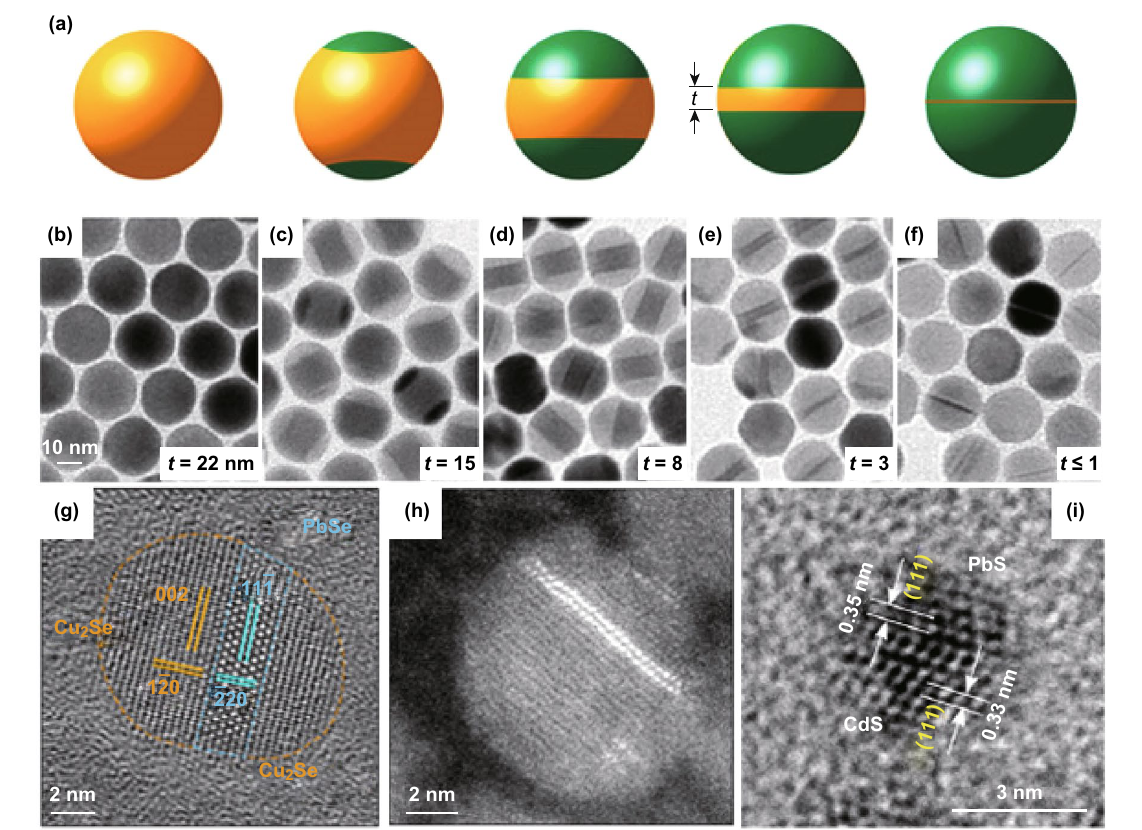
Fig. 3 a Schematic illustration of the cation exchange transformation of Cu 1.8 S NCs into sandwich‑like heterostructures with ZnS caps. b–f TEM images show the composition change from the initial Cu 1.8 S NCs b into ZnS f with a thin layer of Cu 1.8 S. The Cu 1.8 S disk thickness (t) is indicated. Reproduced with permission from Ref. [89]. Copyright 2014, American Chemical Society. g Scanning transmission electron micros‑ copy (STEM) image of a single partially exchanged hexagonal Cu 2 Se NC. Two PbSe stripes in the middle of the NC were observed. Reproduced with permission from Ref. [90]. Copyright 2017, American Chemical Society. h TEM image of partially exchanged CdS QD consisting of a heterostructure of CdS and PbS. i TEM image of partially exchanged CdSe QD. Reproduced with permission from Ref. [91]. Copyright